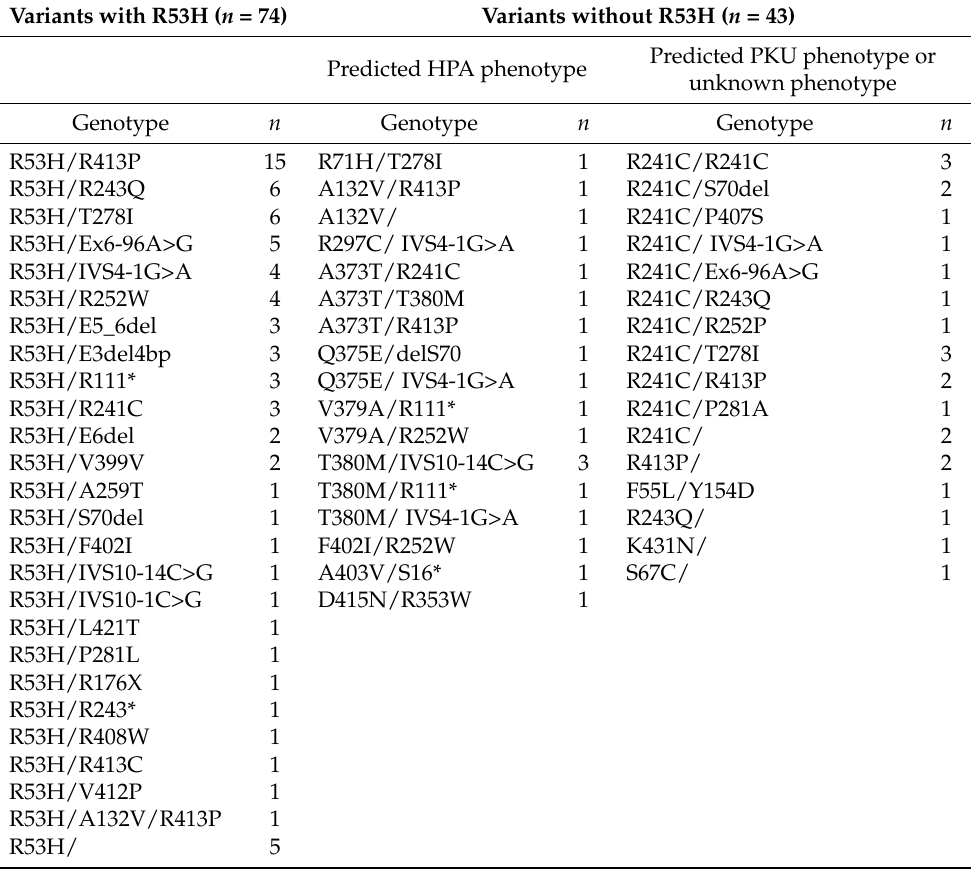
Table 1. PAH variants identified in 117 patients with HPA